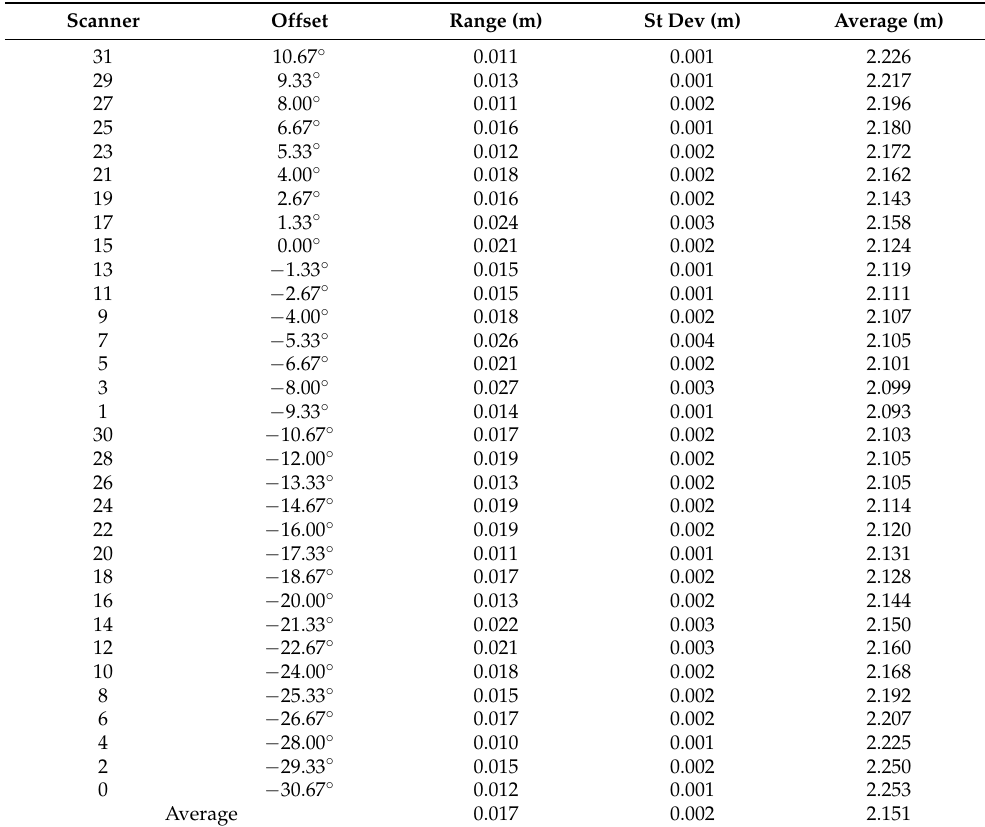
Table 4. Summary of Velodyne ® HDL–32E indoor experiment indoor measurements (average of all points from each scanner within the − 8 ◦ to +8 ◦ scan window).